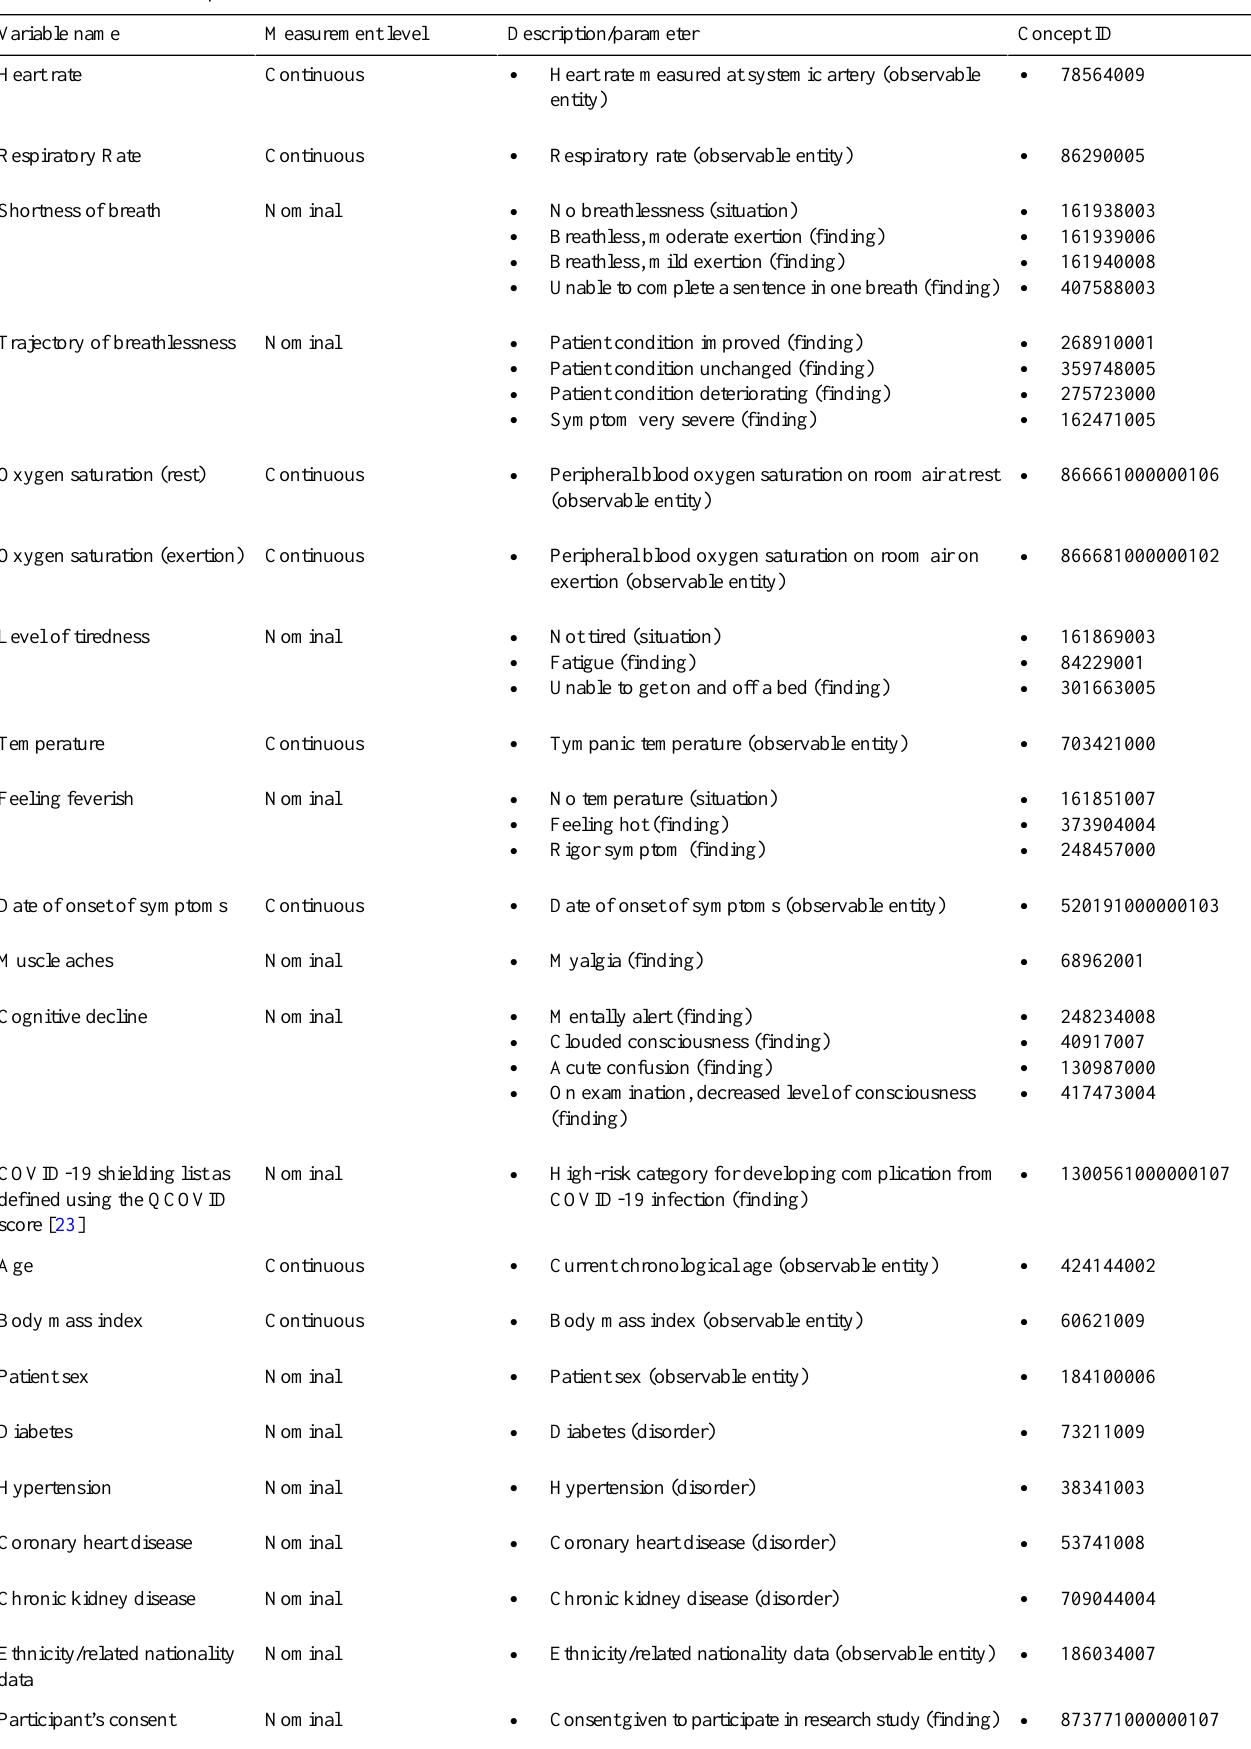
Table 1. RECAP-V0 template